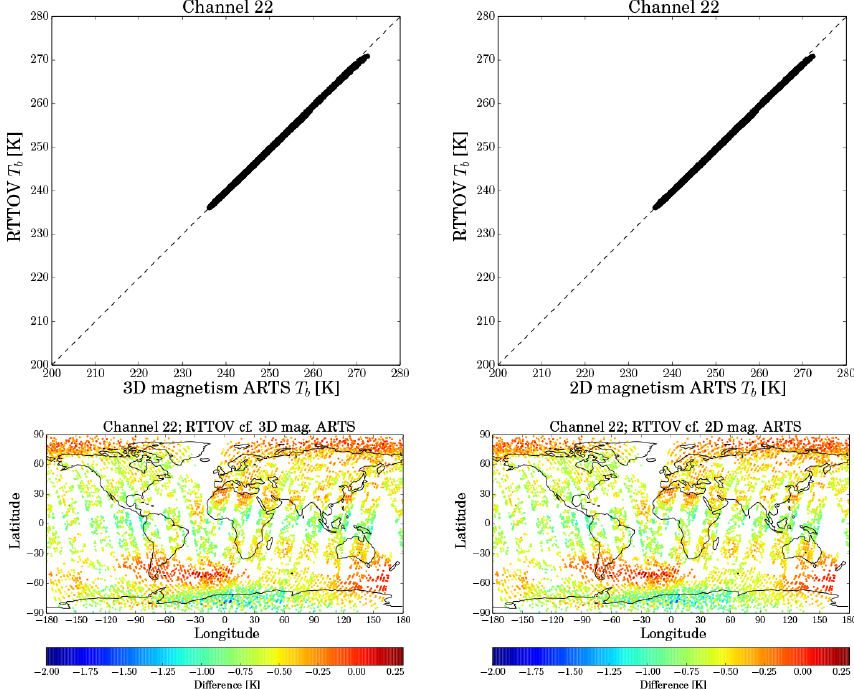
Figure 9. Channel 22 comparison of RTTOV and ARTS simulations as for Fig. 6 but with a fixed color scale.